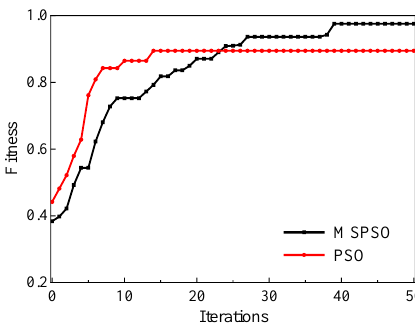
Figure 14. Fitness curve of PSO & MSPSO.